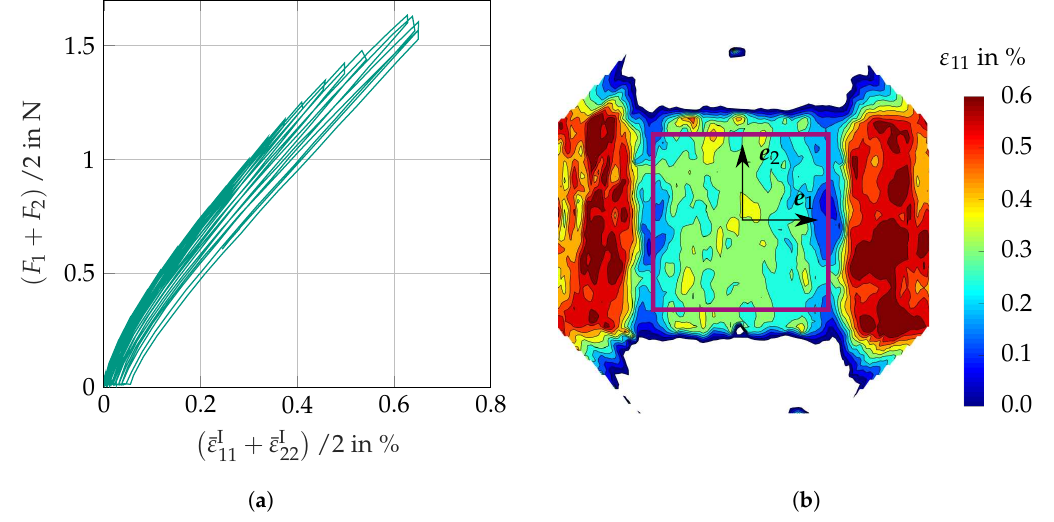
Figure 9. Bonded reinforcements on the arms with loading scenario P Γ = 1 . ( a ) Force over strain, average values over the e 1 - and the e 2 -direction; ( b ) Contour plot of the normal strain ε 11 at ¯ ε I